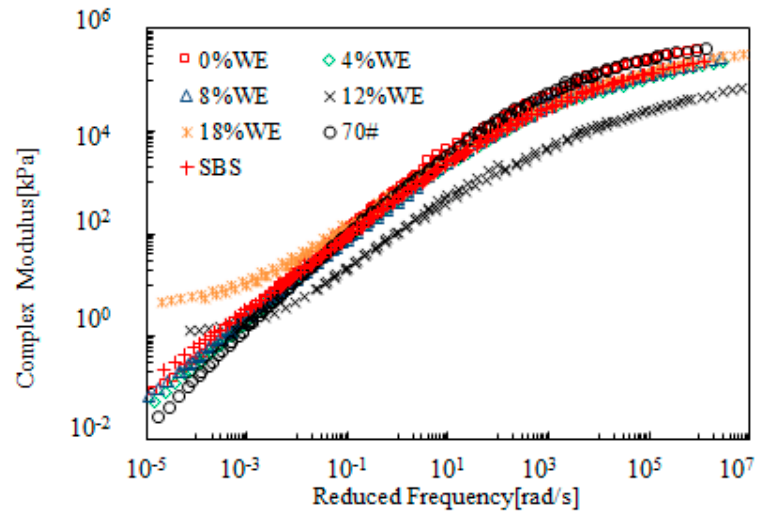
Figure 9. Master curves of the complex modulus of WE-modified bitumen emulsion.